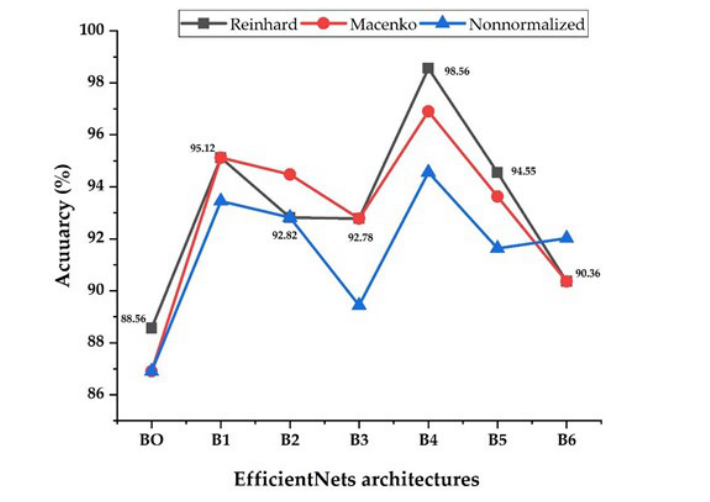
Figure 10. Performance accuracy for the EfficientNet architectures with non-stain-normalized and stain-normalized